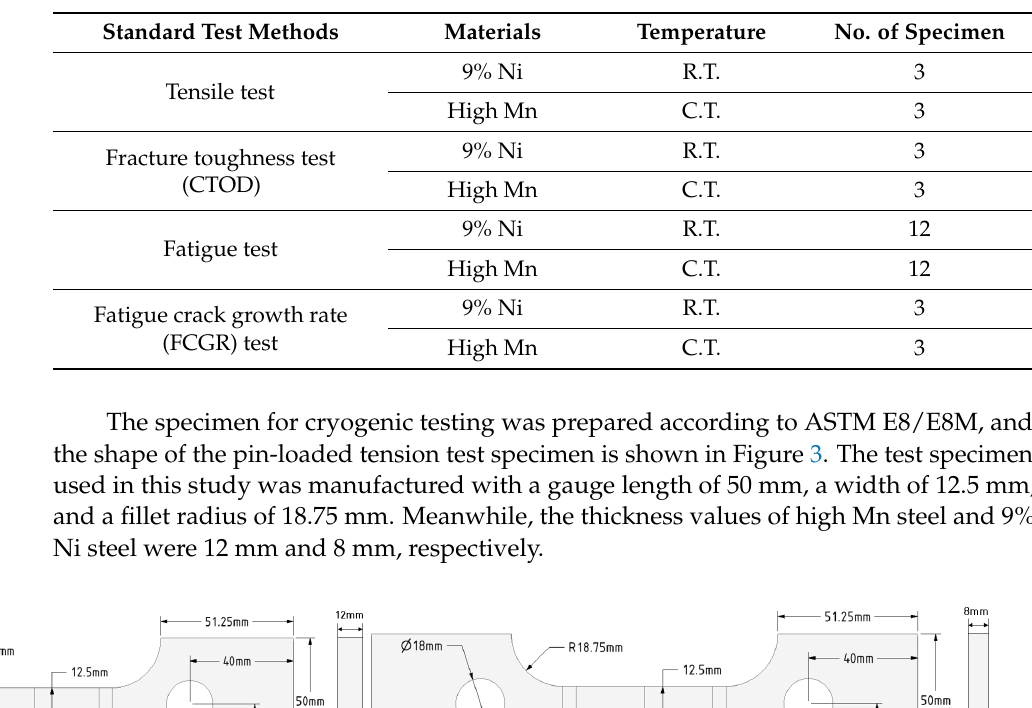
Table 4. The scope of the mechanical properties testing.